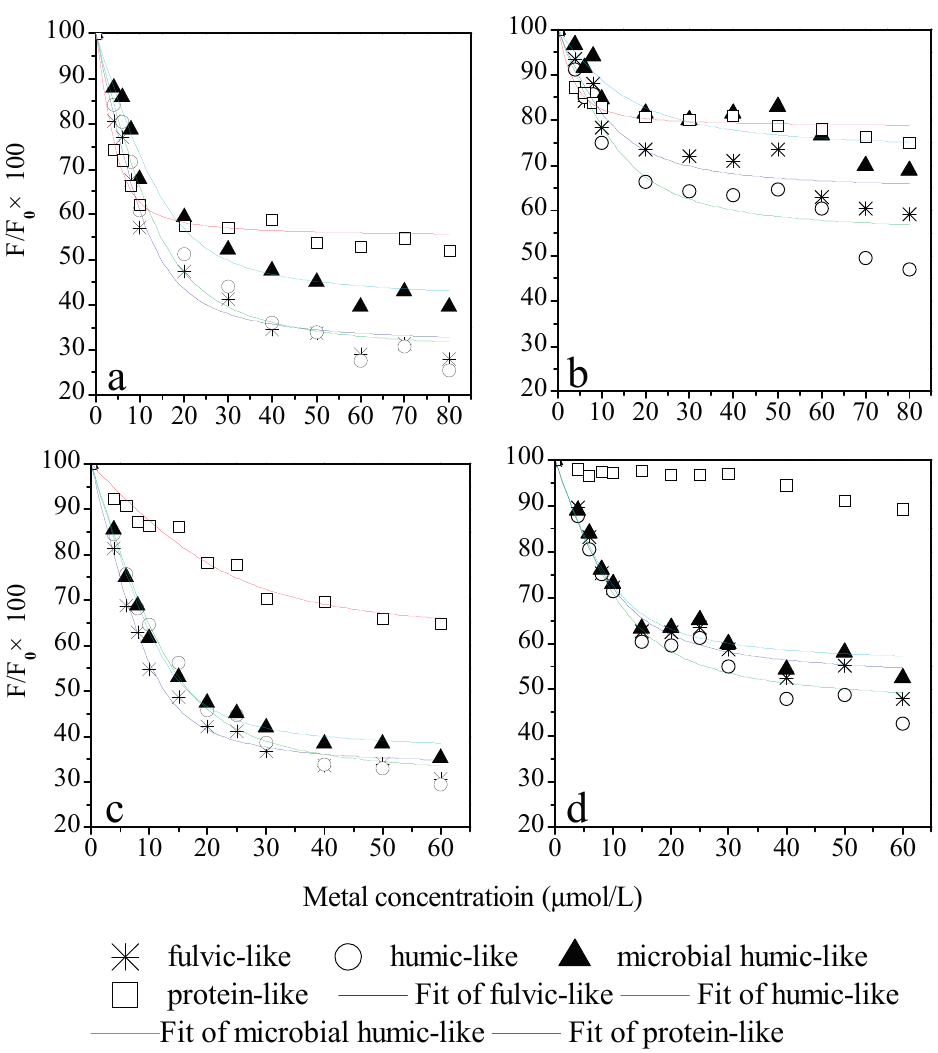
fulvic-like humic-like microbial humic-like protein-like Fit of fulvic-like Fit of humic-like Fit of microbial humic-like Fit of Figure 3. The fluorescence quenching curves of PARAFAC-derived components with Cu (0–80 μ mol/L) ( a ); Cu (0–80 μ mol/L) and Eu (20 μ mol/L) ( b ); Eu (0–60 μ mol/L) ( c ); Eu (0–60 μ mol/L) and Cu (10 μ mol/L) ( d ).